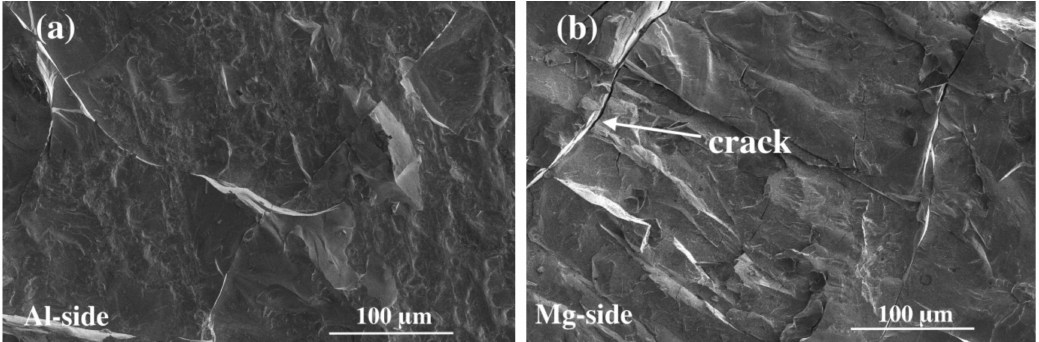
Figure 5. SEM micrographs of the interface for sample I. ( a ) Al-side; ( b )